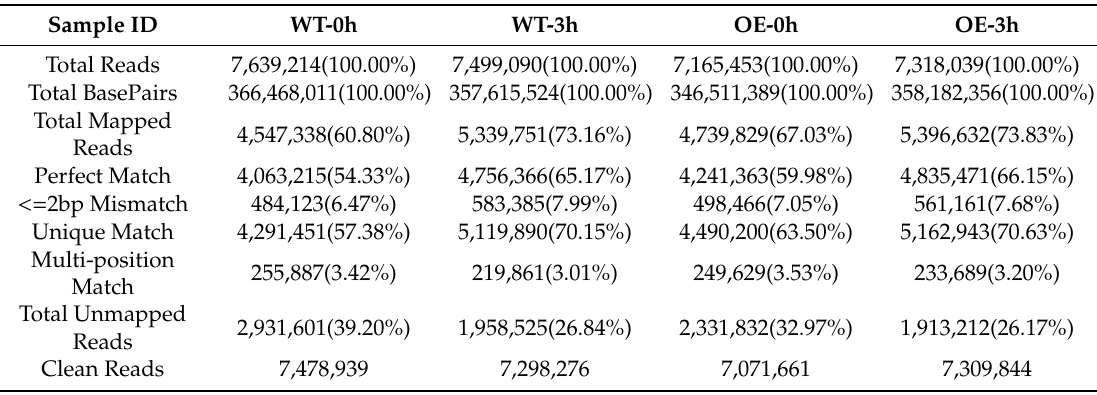
Table 1. Quality of RNA-Seq of ThTrx5 transgenic lines.